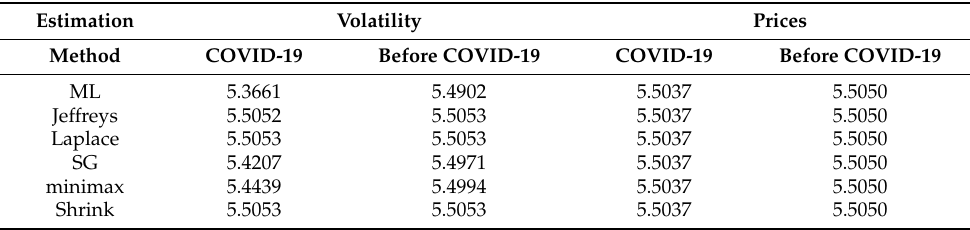
Table 4. Estimates of the Shannon entropy for PSX-100 estimated volatilities and closing prices.